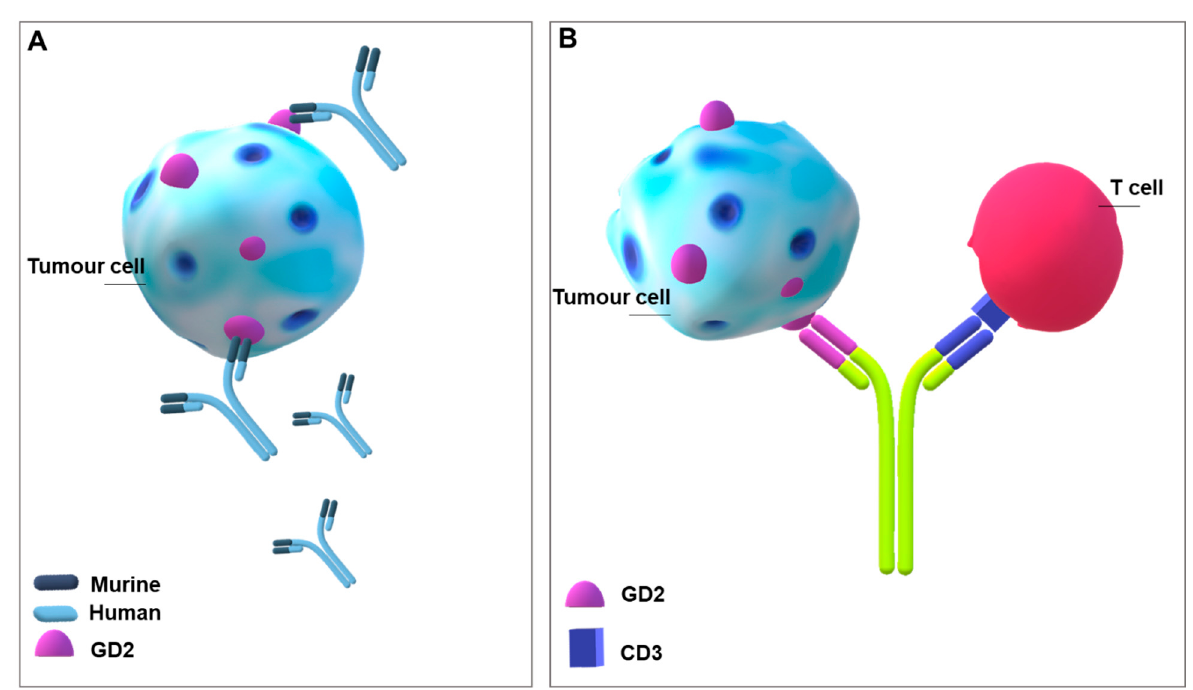
Figure 3. Gangliosides as antigens for building monoclonal antibodies against tumour cells. ( A ) Picture of the mono- clonal antibody Ch14.18 mAb (dinutuximab). ( B ) Illustration of a bispecific antibody targeting tumour-associated GD2 and CD3 on a T cell.